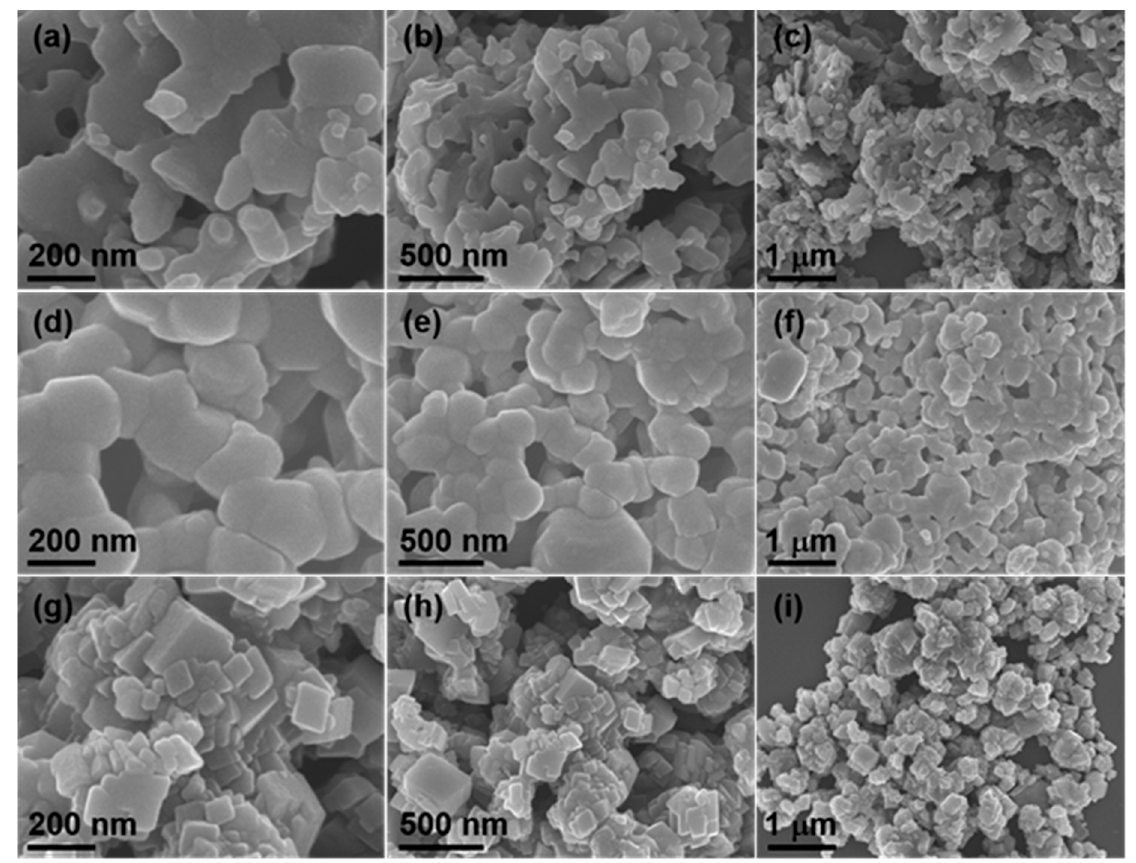
Figure 4. SEM images of CCNPs from calcium oleate at different temperatures: ( a – c ) 450 °C, ( d – f ) 500 °C, and ( g – i ) 550 °C.